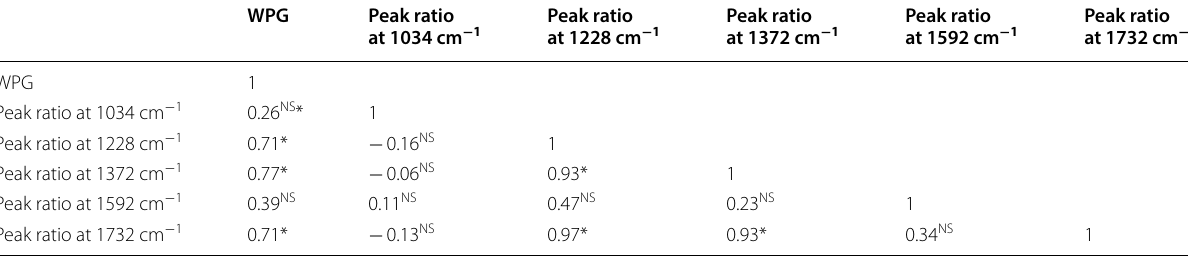
Table 2 Pearson correlation matrix of WPG and ratios of intensity of the transmittance in FTIR spectra of acetylated tropical hardwoods